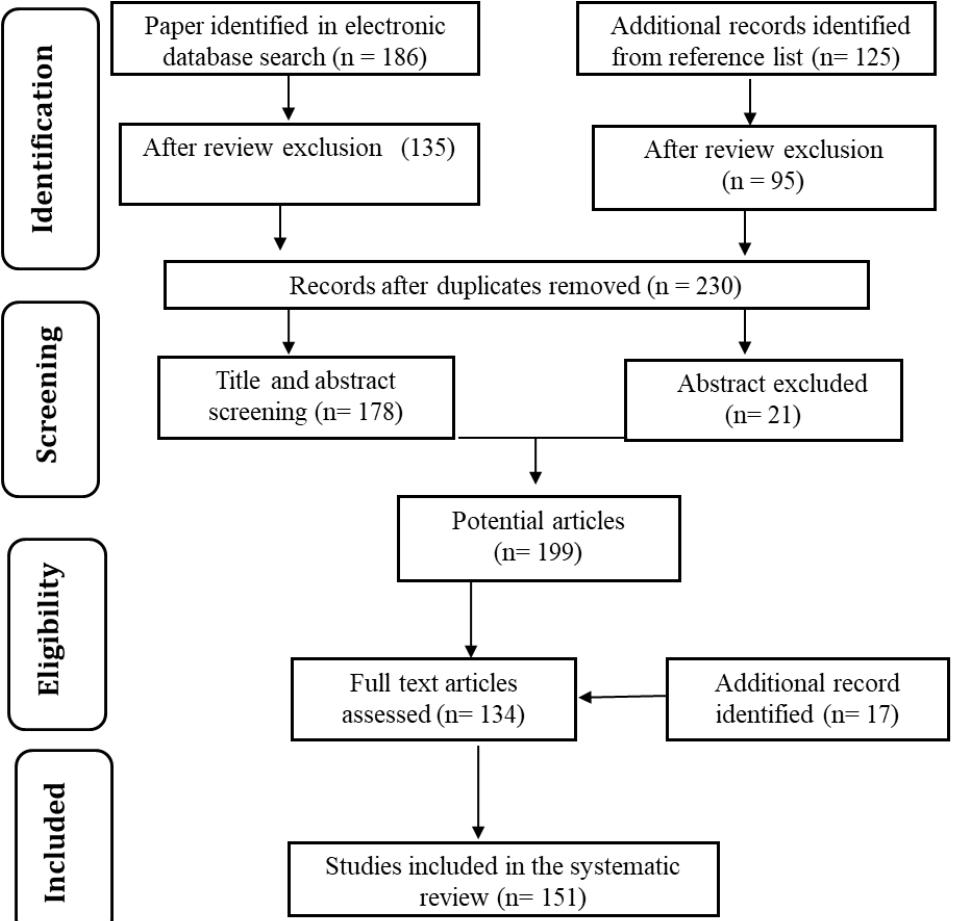
Figure 3. Flowchart of identification and selection strategy used for research articles.